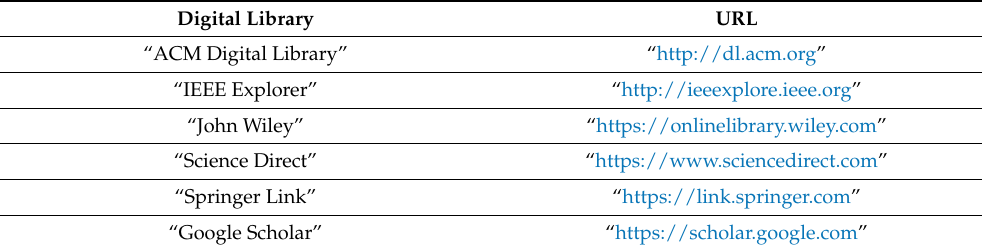
Table 1. Data sources for SLR data